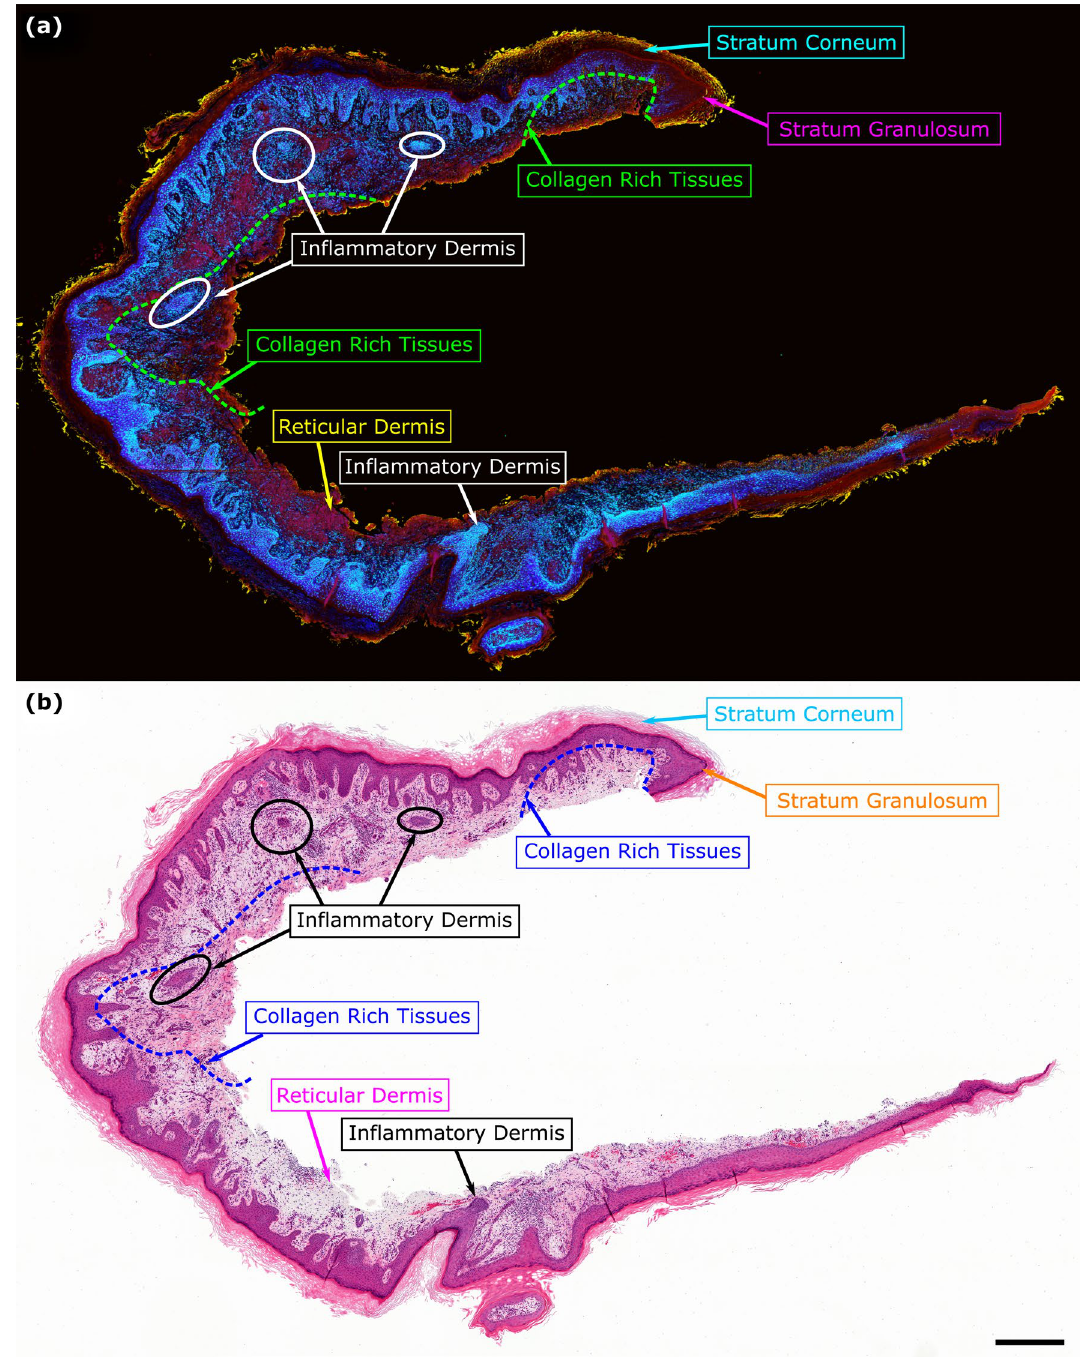
Figure 8. TA-PARS QER imaging in a thin section of human skin tissues. ( a ) TA-PARS QER colorization in human skin tissues from a resection margin of squamous cell carcinoma (SCC). The quantum yield highlights different biomolecules (e.g., nuclei in blue). ( b ) Corresponding image of the exact same section of human skin tissues once stained with H&E dyes. Scale Bar: 1 tary Information Sect. 4: Fig. S20 to Fig. S21. As in the thin tissue sections, the high QER biomolecules (DNA, RNA, etc.) appear as a light blue color, while the low QER biomolecules (neurons, myelin, etc.) appear orange and purple. Looking at the QER visualization in the bulk tissue section (Fig. 9c), several diagnostic features may be identified. Within the red outline (right side) is a region of presumed gray matter. This region features enlarged nuclear elements indicating the nucleus of neuronal bodies and glial cells present in grey matter areas. Inside of this region, there is a split in the tissues likely caused by tissue handling. Concurrently, encircled in green is the presumed oblique section of a vessel discernable based on the distinct elongated shape, and densely